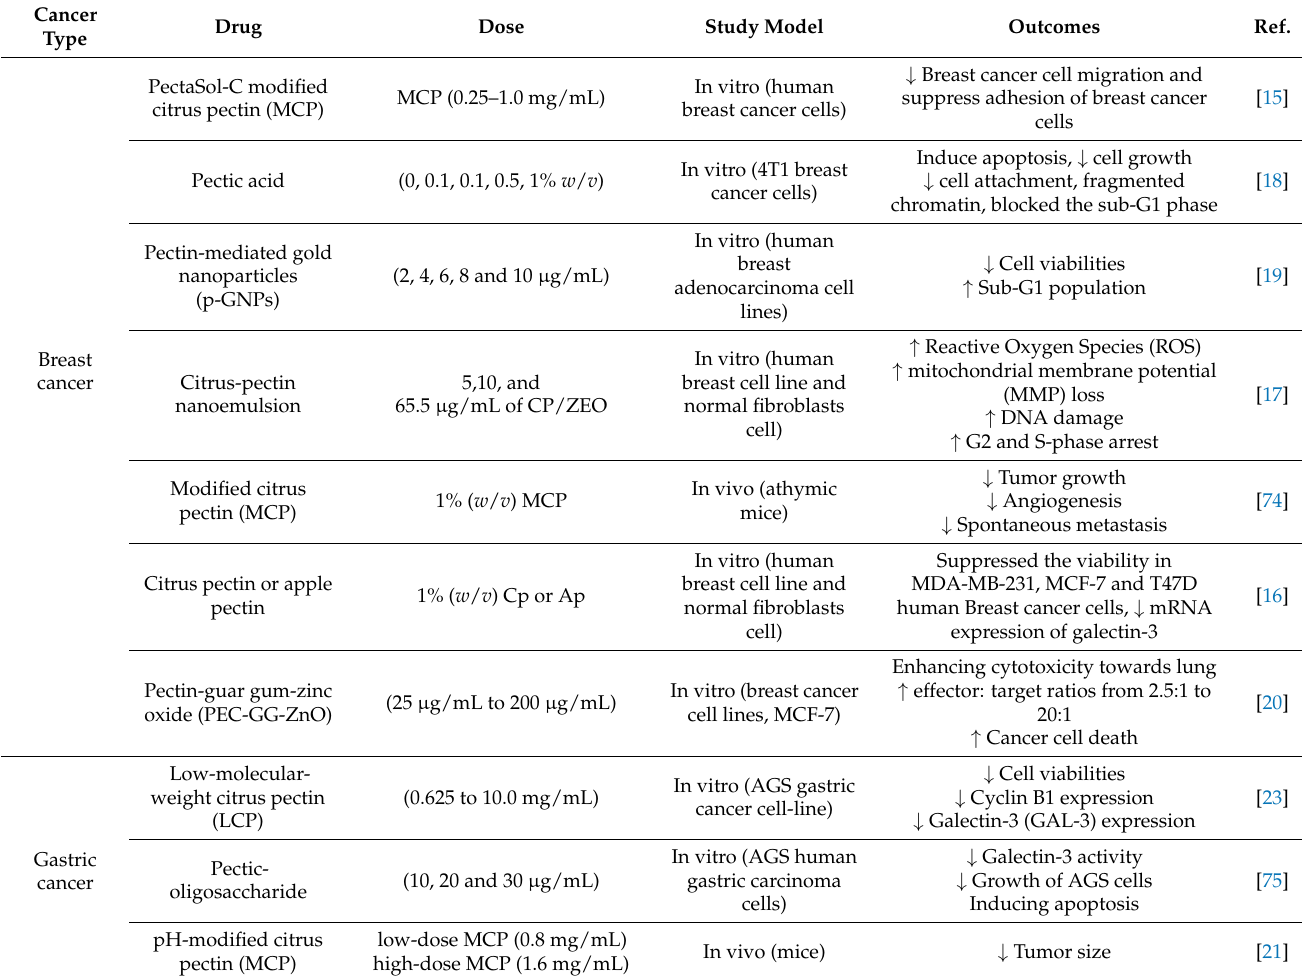
Table 1. Preclinical experimental evidences on the use of pectin and modified pectins in cancer. Study Model Outcomes